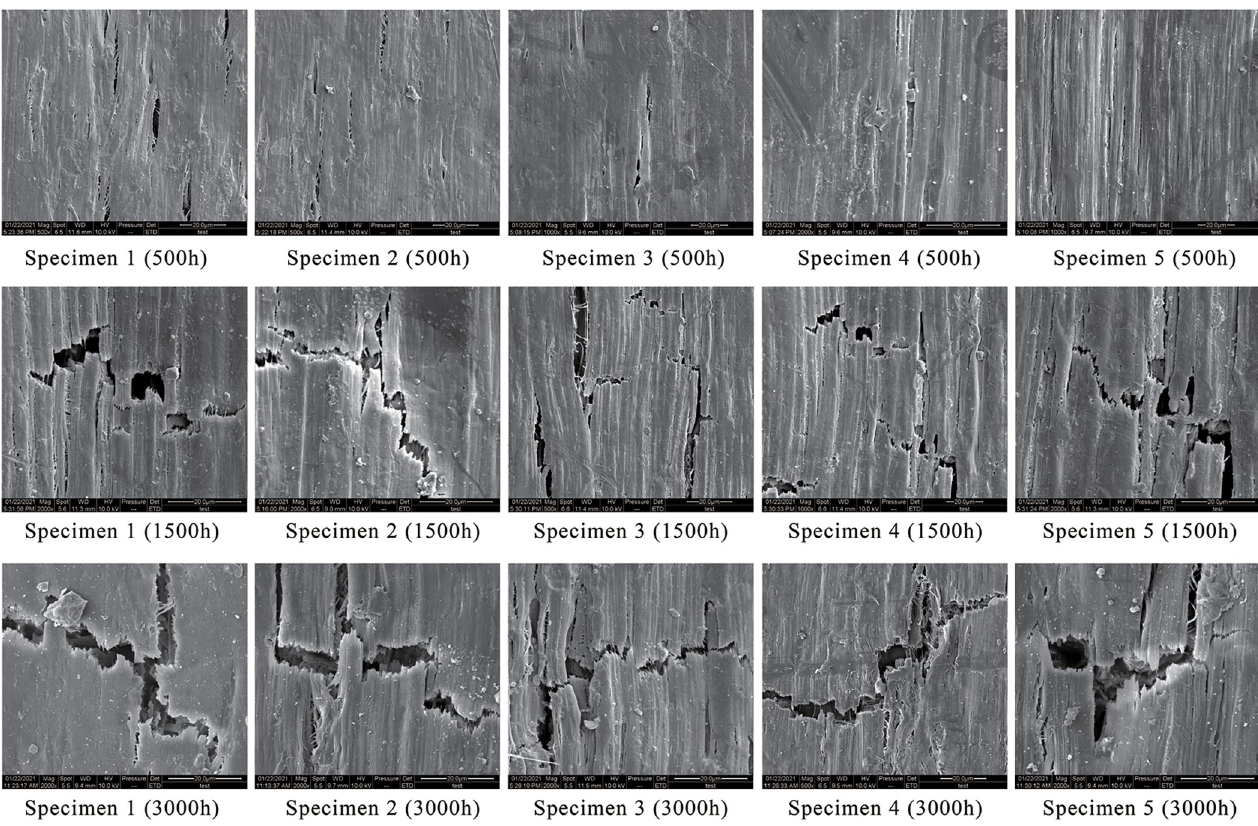
Fig 7. Surface microstructures after UV-accelerated